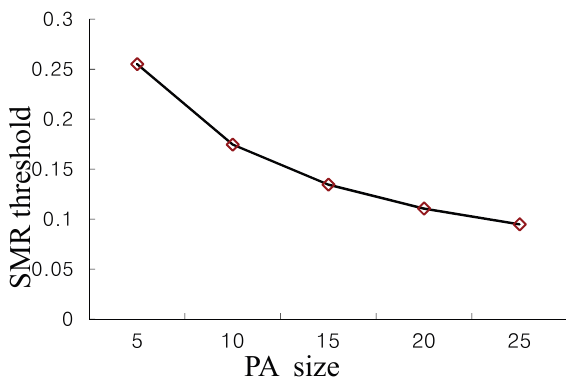
Figure 8. SMR threshold according to PA size.